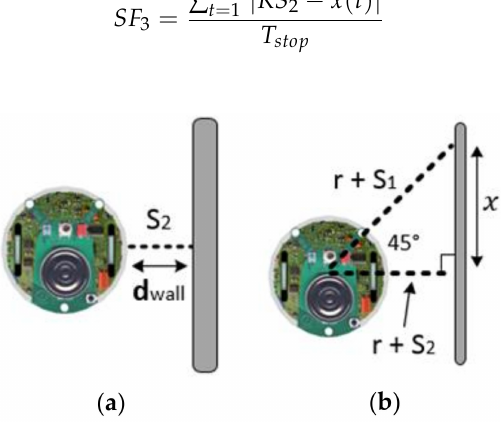
Figure 11. ( a ) Average distance; ( b ) Parallel degree.